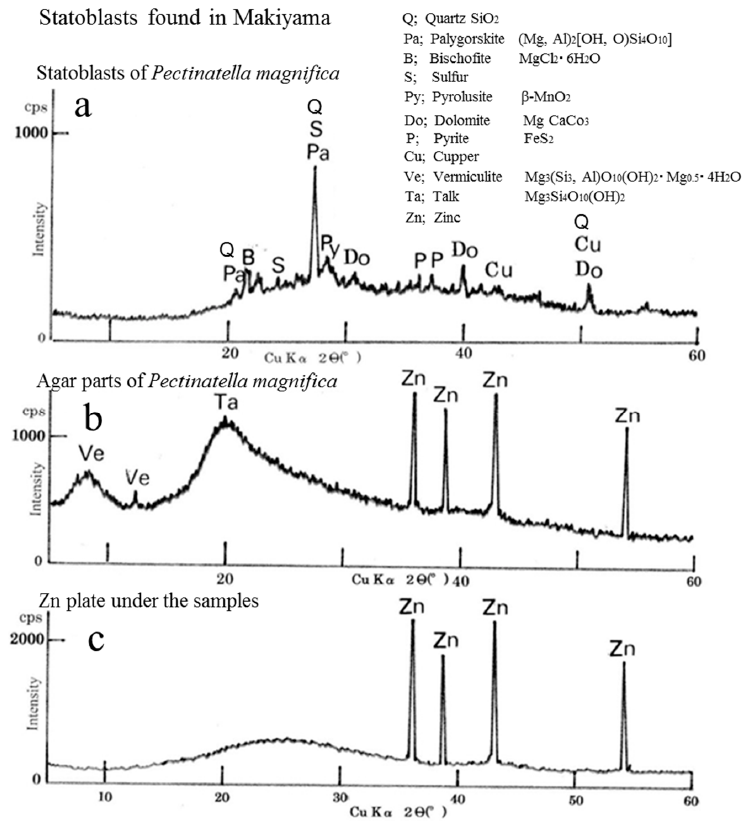
Figure 6. XRD results for the statoblasts gathered on the surface of Pectinatella magnifica ( a ); the gelatinous material (agar parts) of this species ( b ); and the sample holder of zinc board and glass filter without the samples ( c ), showing the existence of various types of minerals.